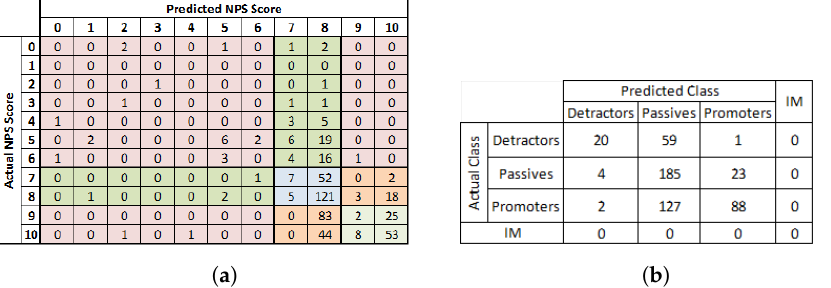
Figure 6. The reduction in the 11 × 11 NPS classification confusion matrix into a 3 × 3 + IM reduced confusion matrix. ( a ) The 11 × 11 NPS confusion matrix. ( b ) The reduced 3 × 3 + IM confusion